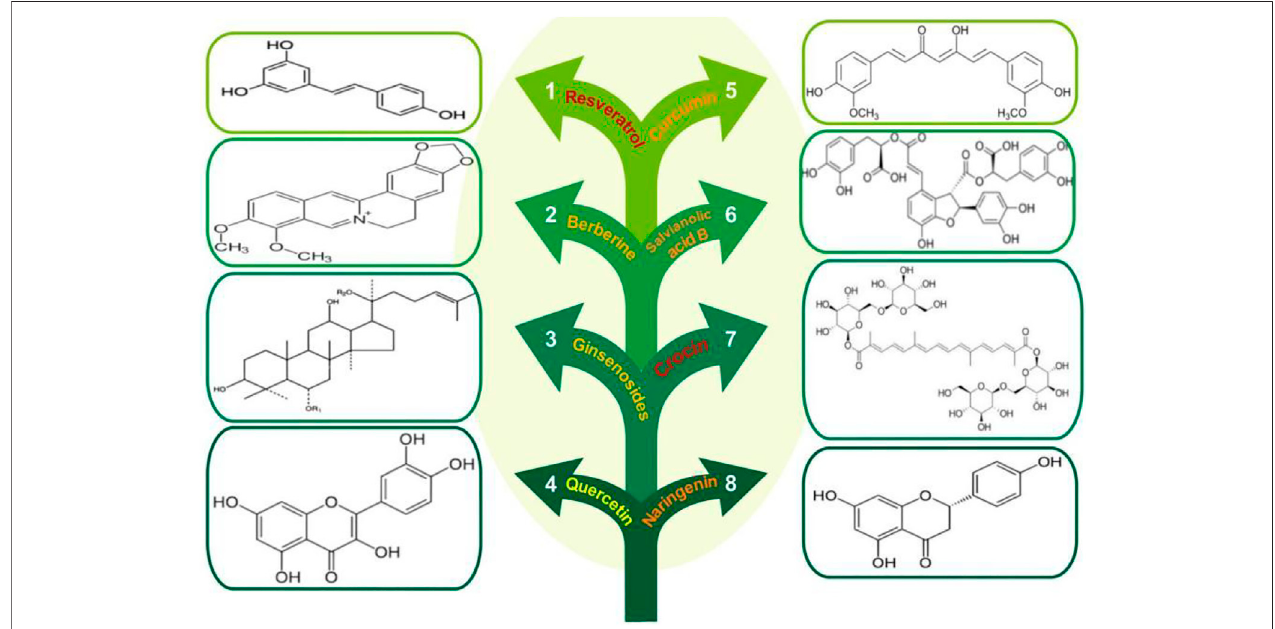
FIGURE 1 | Chemical structures of the natural AMPK